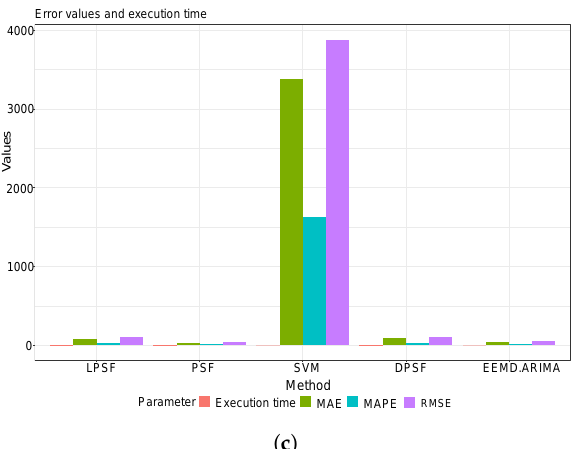
Figure 6. The bar chart of the performance metrics and time execution results of solar radiation forecasting for the daily ( a ), weekly ( b ) and monthly ( c ) at Robinson station.